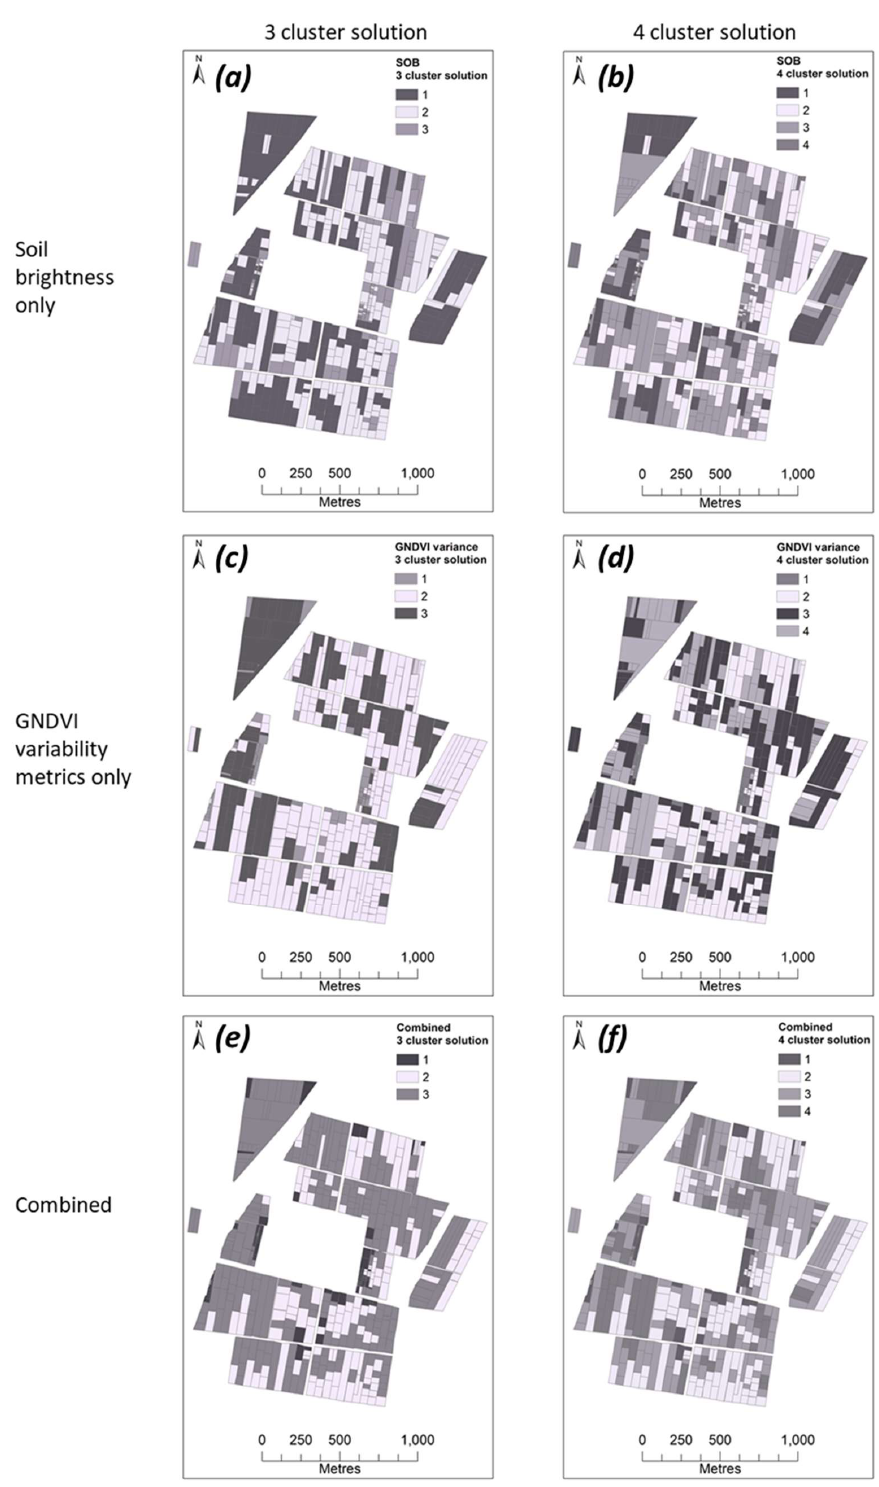
Figure 8. Results of clustering at field scale using ( a , b ) soil brightness alone; ( c , d ) the GNDVI variability metrics and ( e,f ) both combined, testing three and four cluster solutions.